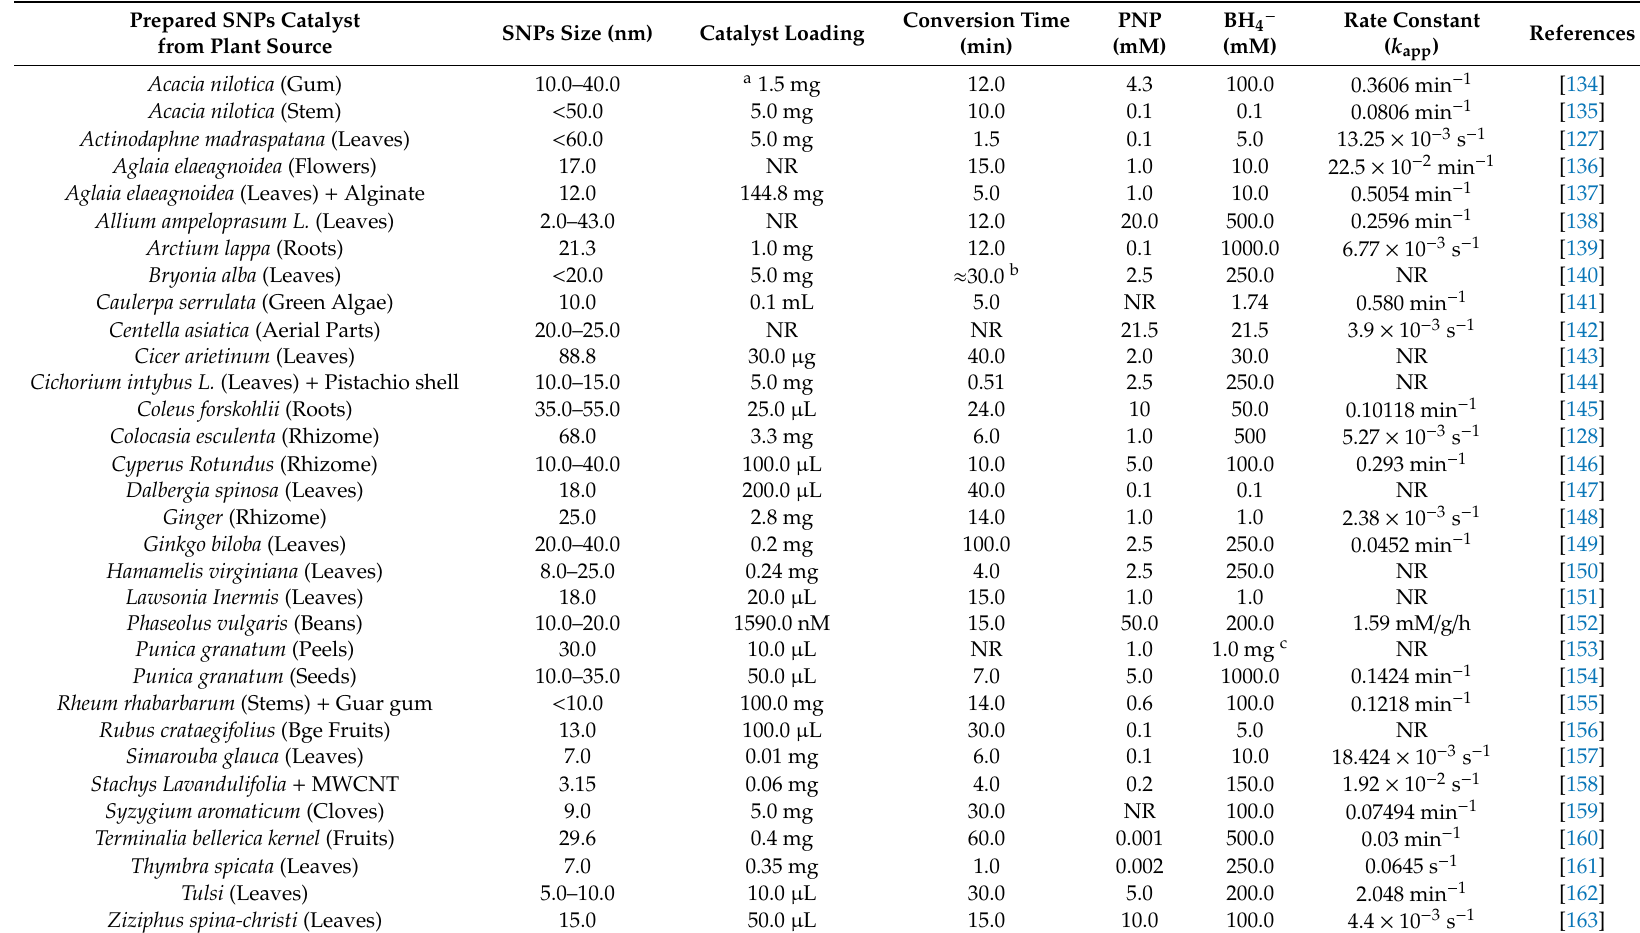
Table 2. Partial list of catalytic reduction reaction parameters of PNP to PAP reported for ecofriendly SNPs in the